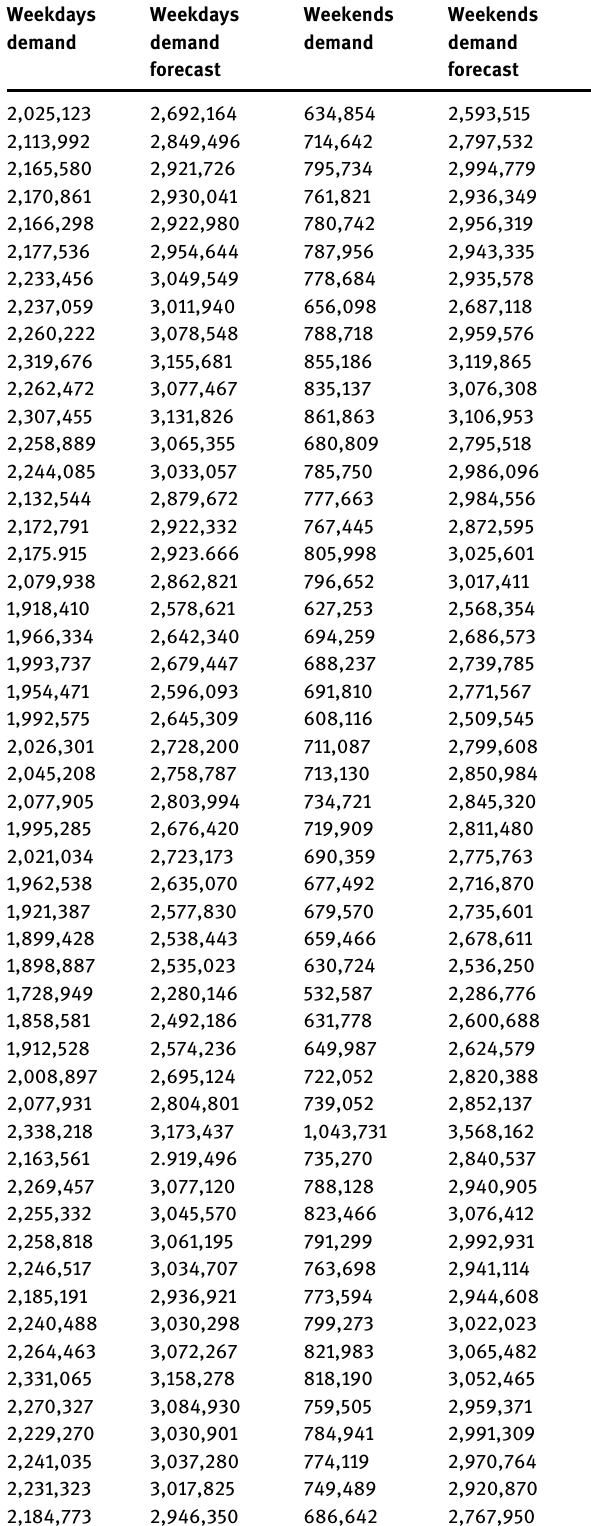
Table 6: Previous period data and simple average method outputs Weekdays